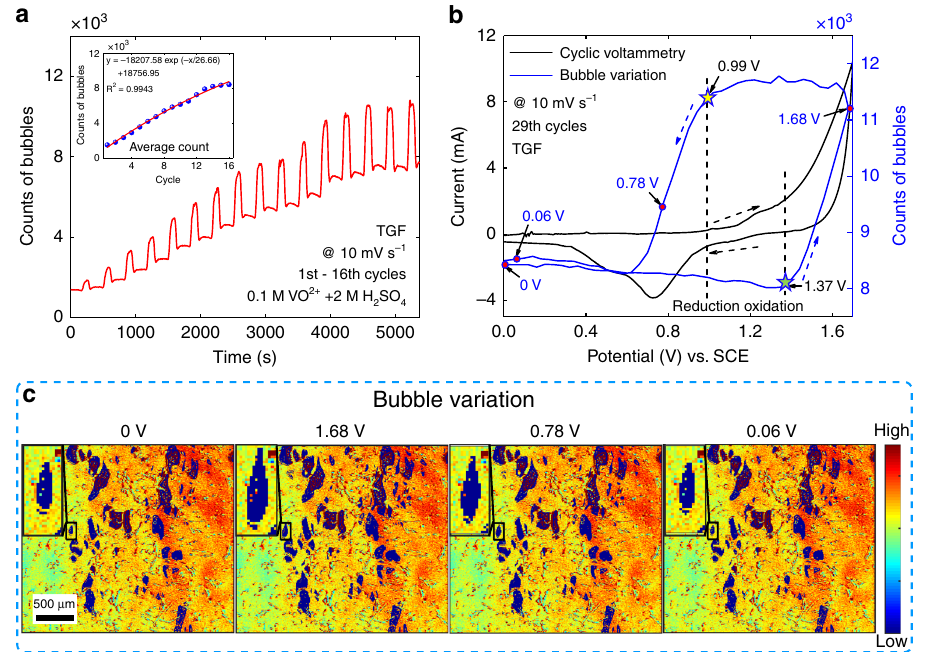
Fig. 4 Bubble kinetics of oxygen evolution reaction in long-term cyclic voltammetry (CV). a The counts of bubbles in the 1st to 16th cycles during long-term CV of the TGF in the positive electrolyte of 0.1 M VO 2 + and 2 M H 2 SO 4 at a scan rate of 10 mV s − 1 recorded by the TIRi sensor. Inset, the average counts of bubbles in each cycle and the fi tting curve. b CV curve of the TGF in the positive electrolyte of 2 M H 2 SO 4 and the counts of bubbles via the sweep potential in the 29th cycle. Black and blue dashed arrows indicate the potential sweep direction. Dashed lines point out the onset oxygen generation (green star) potential and consumption (yellow star) potential. c Bubble variation in combination with the mapping of the peak oxidation current densities |i pa | at the potential of 0, 1.68, 0.78, and 0.06 V during the 29th